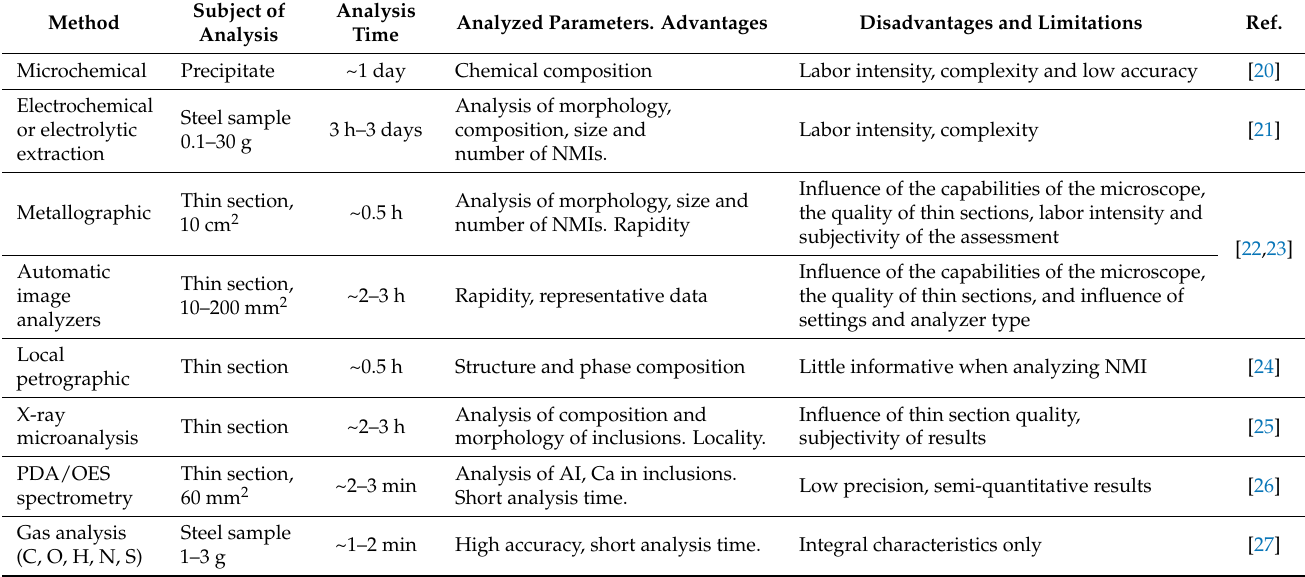
Table 2. Comparison of various methods for evaluation of non-metallic inclusions and clusters in metal